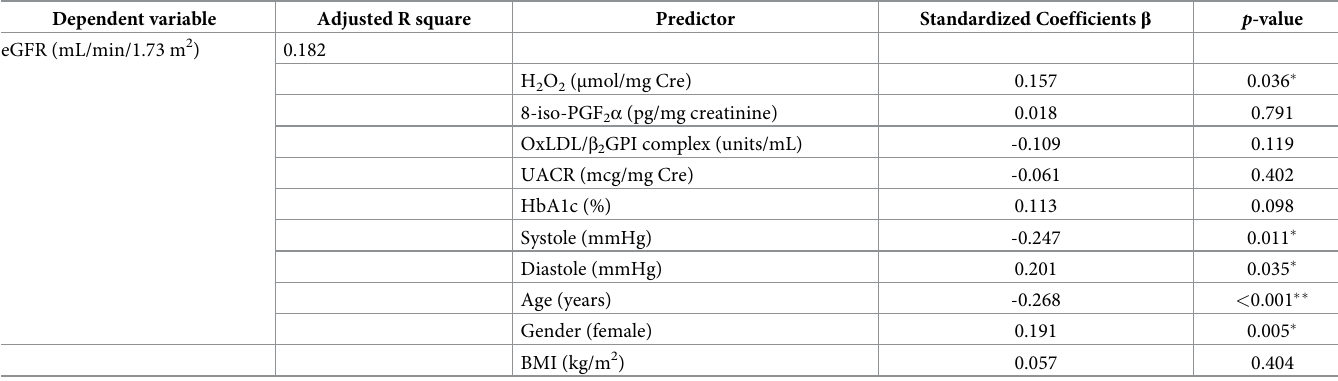
Table 3. Factors affecting the eGFR level in T2DM patients (n =